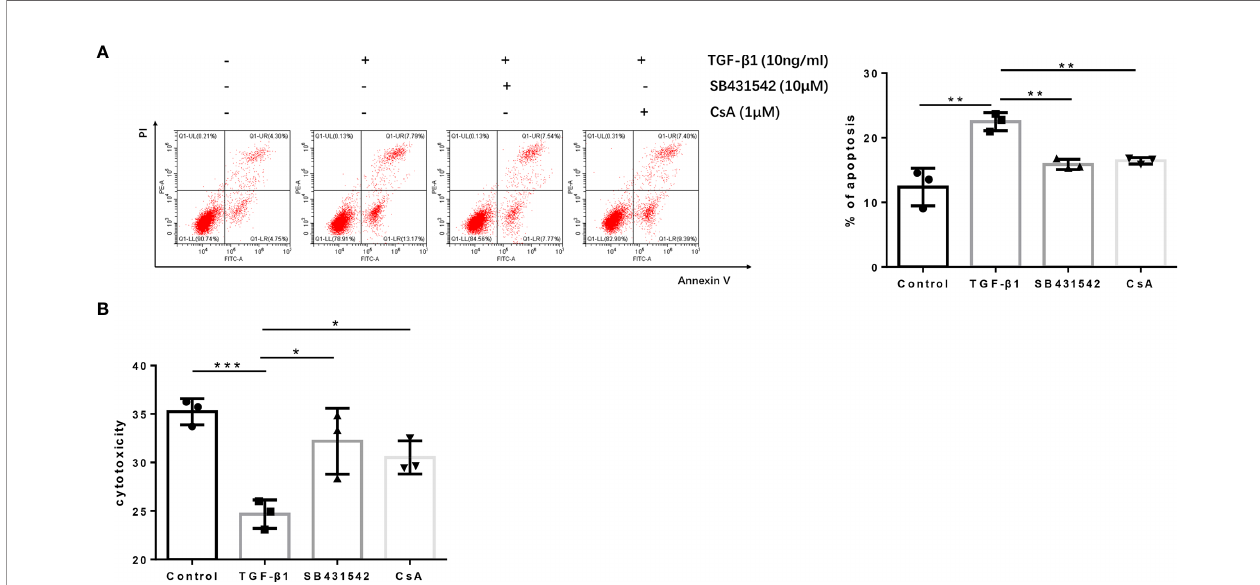
FIGURE 7 | Blockage of the TGF- b receptor or CaN/NFATc1 pathway recovers the cytotoxicity of H9 cells. (A) Flow cytometry was used to detect the apoptosis of T cells after co-culture with Bel-7404 cells for 24 h. (B) CCK-8 reagent was used to detect the cytotoxicity of T cells for Bel-7404 cells after co-culture with Bel-7404 cells for 24 h. n = 3, *P < 0.05, **P < 0.01, ***P < 0.001 vs. control group.